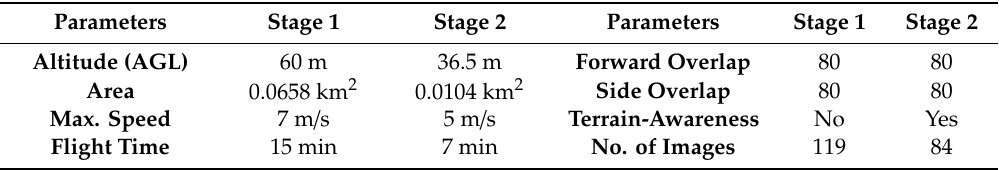
Table 2. Flight parameters for Stage 1 and Stage 2 flight